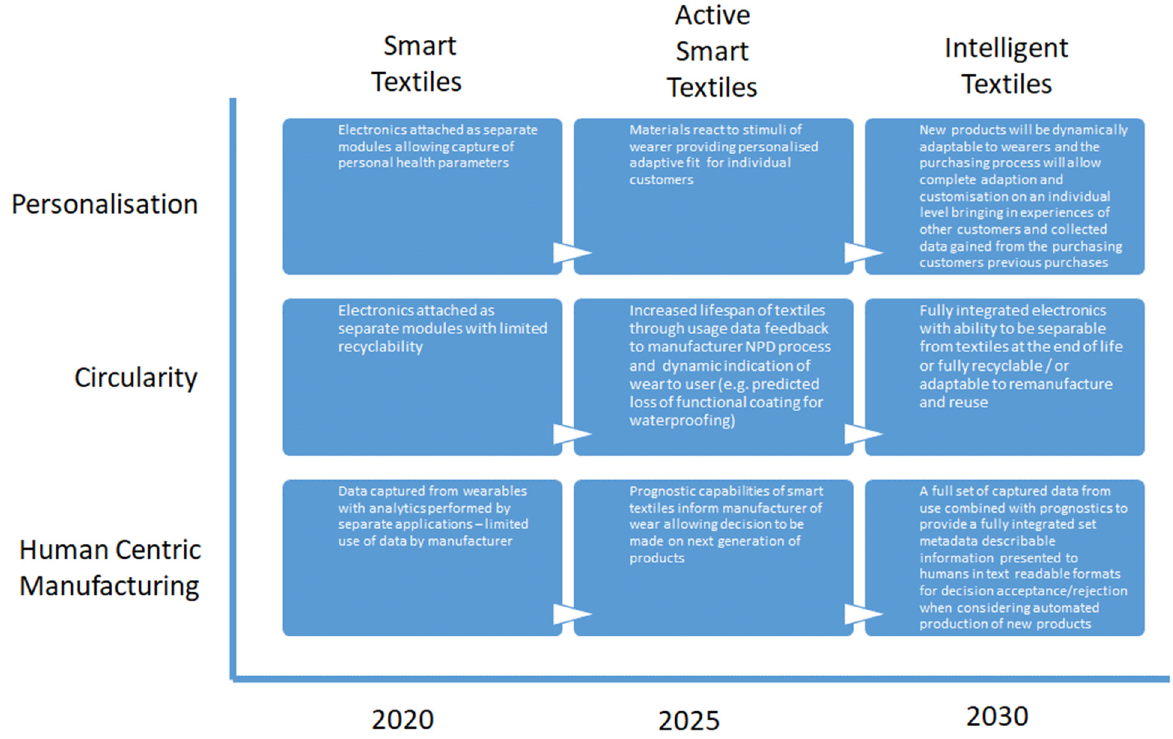
Figure 3. 3D/4D printed smart fabrics Development with implications for Personalisation, Circularity and Human Centric Manufacturing (adapted from Lancos et al.